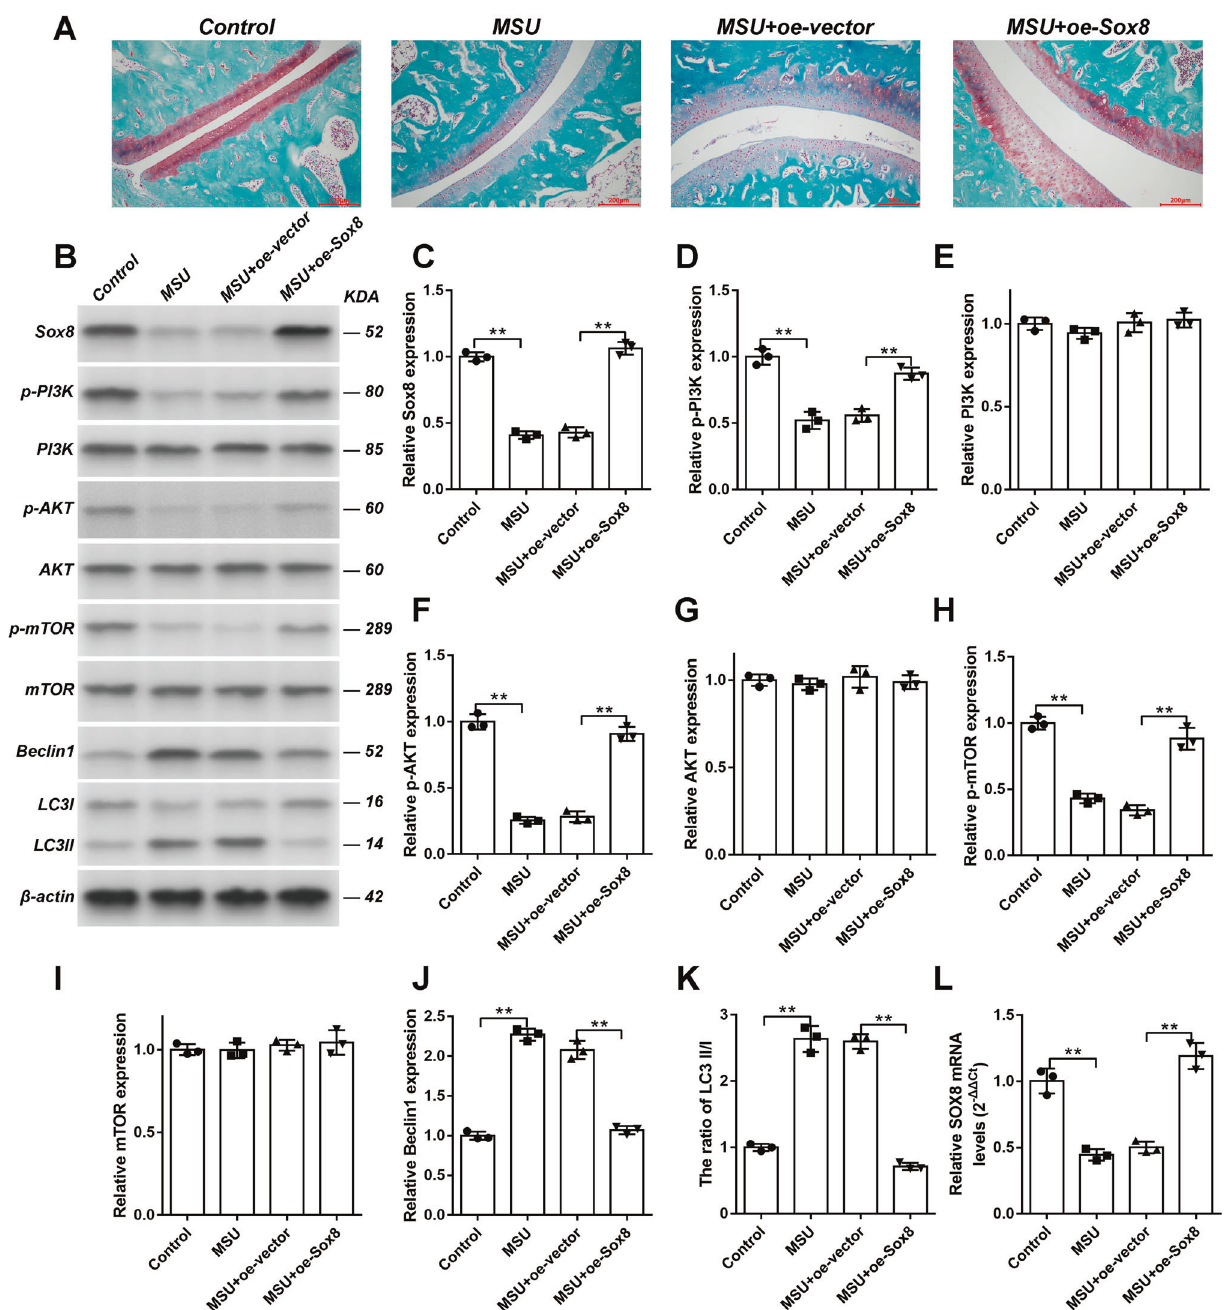
Fig. 8 Effect of Sox8 overexpression on cartilage and PI3K/AKT/mTOR signaling pathway in MSU-induced gouty arthritis rat model. The right ankle joints of the rats were injected with oe-vector or oe-Sox8. Followed by, the injection of 100 μ L of MSU (30 mg/mL) the next day. The rats were sacri fi ced on day 3 after MSU injection. Safranin-O/fast green staining of the right ankle joint for each group ( A ), bar = 200 μ m. The expression levels of Sox8 ( B , C ), p-PI3K ( B , D ), PI3K ( B , E ), p-AKT ( B , F ), AKT ( B , G ), p-mTOR ( B , H ), mTOR ( B , I ), and Beclin1 ( B , J ) and the ratio of LC3-II/I ( B , K ) in the right ankle cartilage were detected by Western blot assay. The mRNA levels of Sox8 ( L ) in the right ankle cartilage were measured by qPCR. Results are the mean ± SD for three individual experiments. * P < 0.05, ** P <